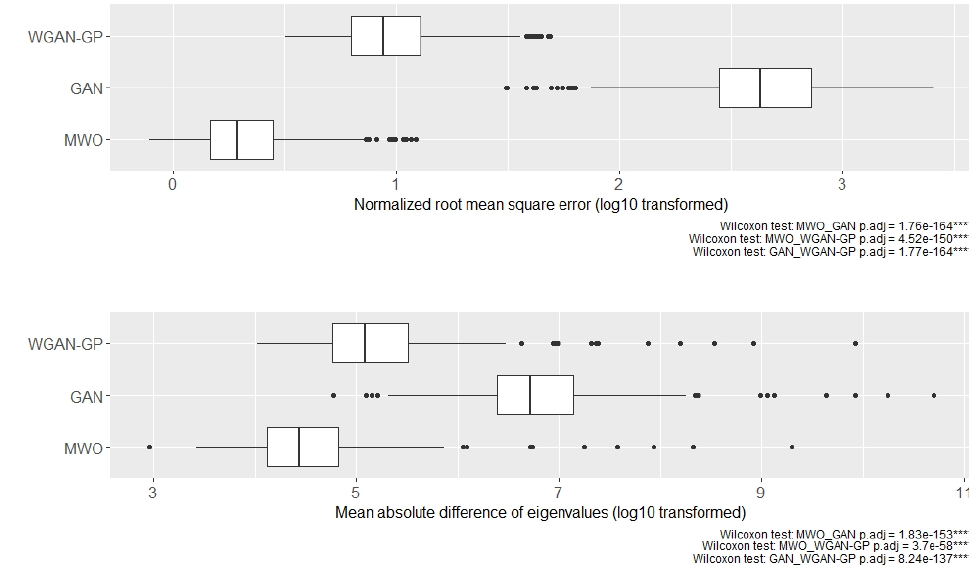
Figure 7. Boxplots of log-transformed normalized mean square errors ( top ) and log-transformed mean absolute differences of eigenvalues ( bottom ) for the RNA-seq experiment when comparing the covariance matrices of artificial and original data. The boxplots contain results for 500 runs, in each of which 50 genes were drawn at random and the correlation matrices were created. The symbol **** denotes p -value <